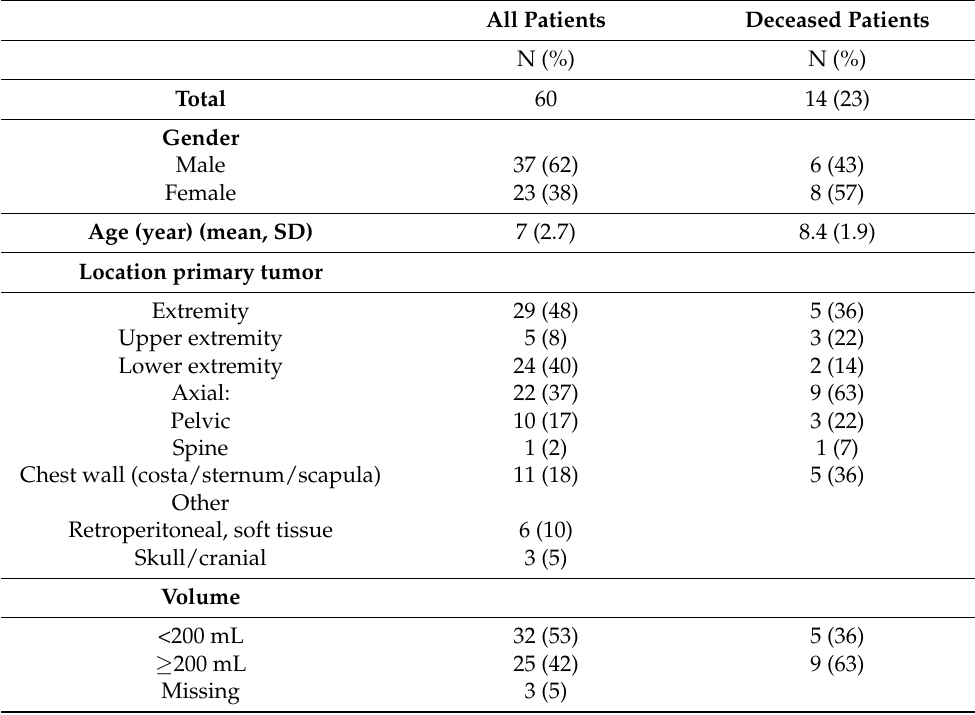
Table 1. Patient demographics of all patients and a subset of patients that died.